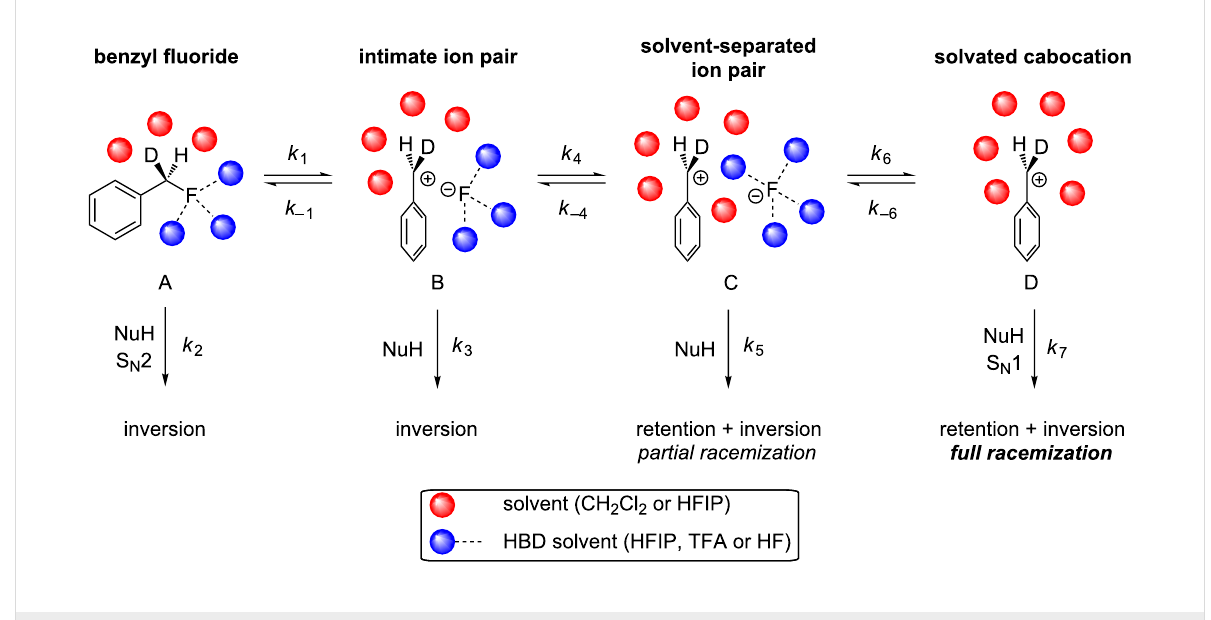
Figure 4: Possible reactive intermediates for C–F activation of benzyl fluoride 1 with strong hydrogen bond donors.